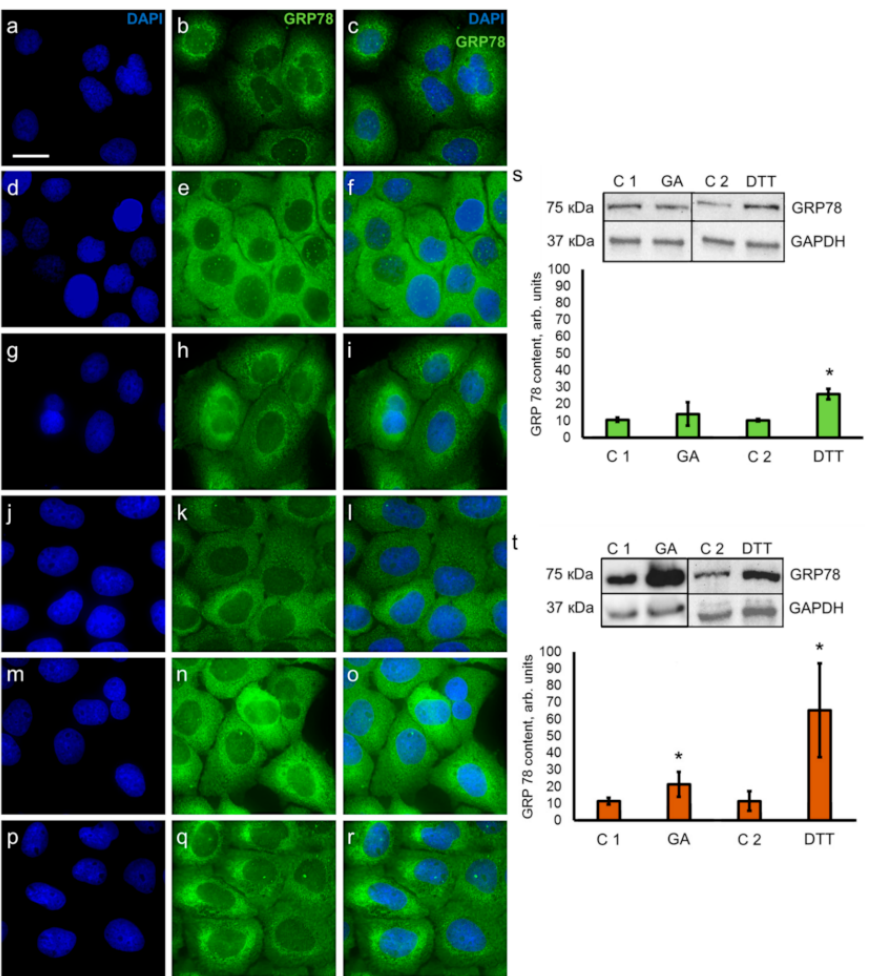
Figure 2. Immunocytochemical visualization of GRP78 localization and analysis of GRP78 content in keratinocytes HaCaT and carcinoma A431 cells. ( a – i ) Keratinocytes HaCaT in control specimens ( a – c ) and in the presence of DTT ( d – f ) and GA ( g , h ); ( j – r ) carcinoma A431 cells in control specimens ( j – l ), in the presence of DTT ( m – o ) and GA ( p – r ). Nuclei are stained with DAPI (left column); GRP78 is visualized with anti-GRP78 antibodies (middle column), merged images (right column). Scale bar, 20 µ m. Western blot analysis and evaluation of GRP78 content in HaCaT ( s ) and A431 cells ( t ). C1—cells growing with ethanol as a solvent for GA (control for GA); C2—cells growing in standard conditions (control for DTT). Data are shown as mean ± standard deviation ( n = 3–5); * p ≤ 0.05 according to the Mann–Whitney